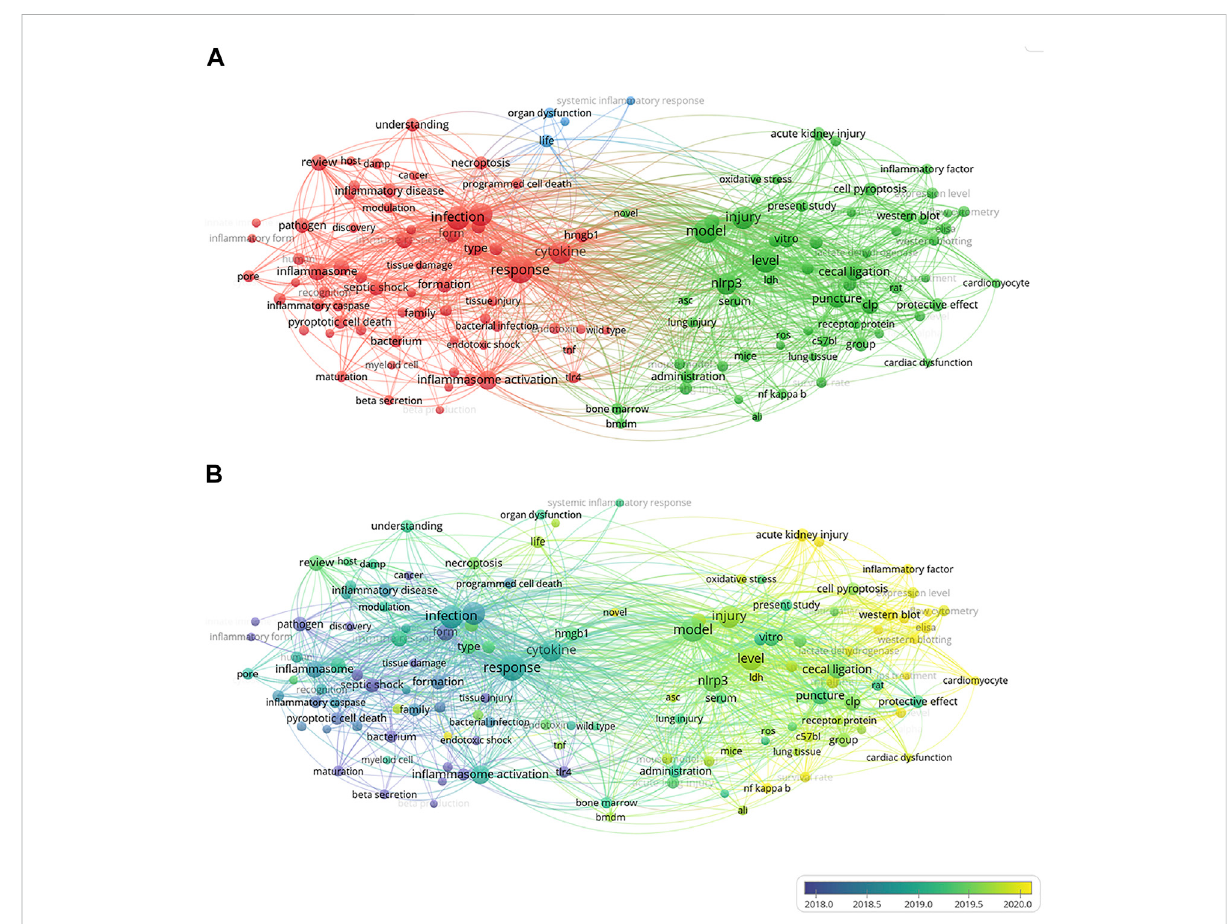
FIGURE 4 The co-occurrence analysis of all keywords in publications of pyroptosis in sepsis. (A) Mapping of the keywords in the area of pyroptosis in sepsis. The words were divided into three clusters in accordance with different colors generated by default: “ animal research ” (right in green), “ cell research ” (left in red), and “ molecular research ” (up in blue). The size of the circle represented the frequency of keywords; (B) The distribution of keywords was presented according to the average time of appearance. The blue color represented early appearance, and the yellow color stood for late appearance. Two keywords were considered co-occurred if they both occurred on the same line in the corpus fi le. A smaller distance between two keywords indicates relatively higher co-occurrences of the